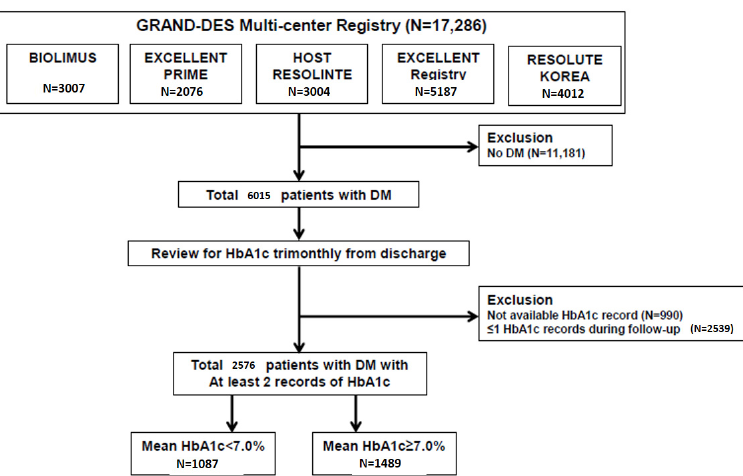
Figure 1. Study flow. From the Grand-DES registry, a patient-level pooled registry including five Korean multicenter prospective drug-eluting stent registries, a total of 17,286 patients with CAD, who had undergone PCI, were screened for inclusion in this study. After collecting the records of HbA1c level trimonthly after discharge, a total of 2576 patients with DM, who underwent PCI and had at least ≥ 2 records of HbA1c, were finally included. Patients were classified according to mean